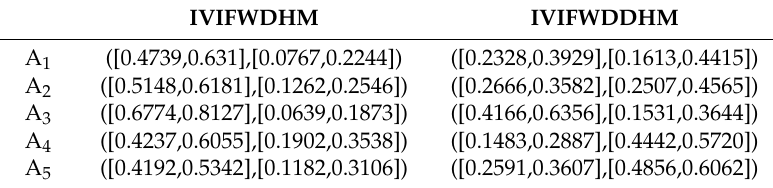
Table 2. The fused results of the tourism scenic spots by the IVIFWDHM (IVIFWDDHM) operator.